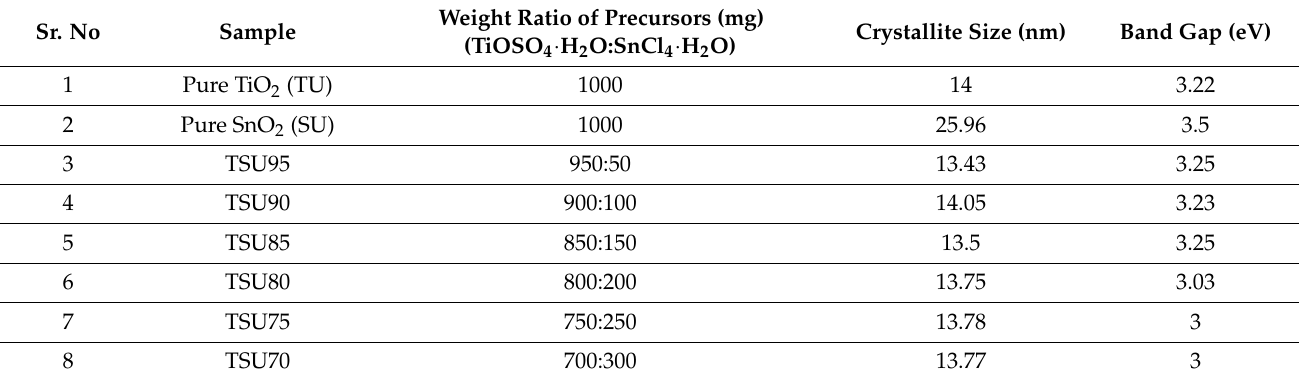
Table 1. Composition, Structural and Optical parameters of as synthesized samples.